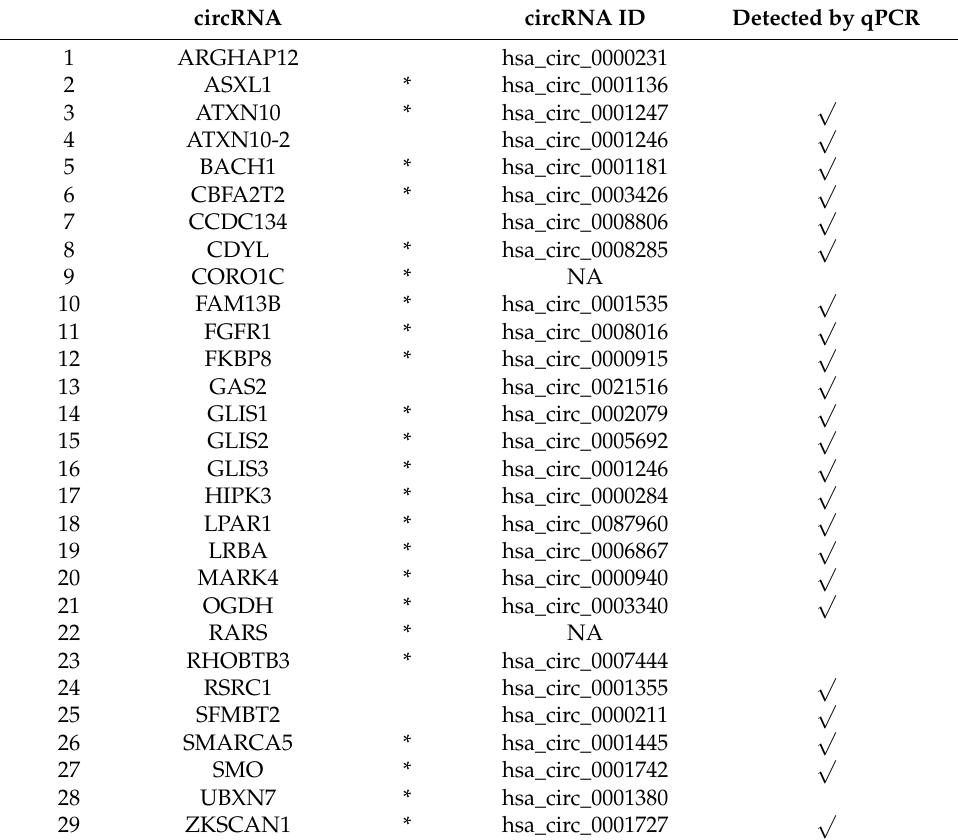
Table 1. Selected and Sanger sequencing validated